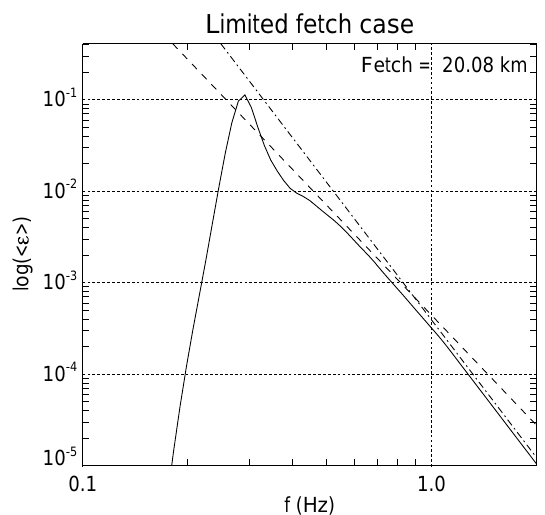
Figure 15. Local mean frequency exponent − q = dln function of dimensionless fetch xg/U 2 for the limited fetch case. Wind speed U = 10ms − 1 – solid line; wind speed U = 5ms − 1 – dashed line. Horizontal dashed line – target value of the self-similar exponent q = 0 . 3.